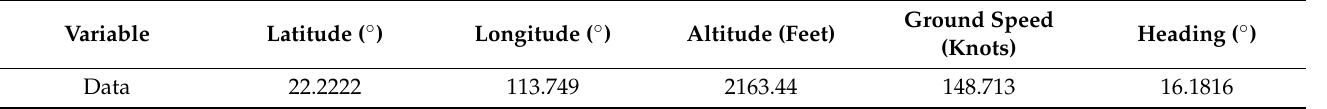
Table 1. CSV data format with sample